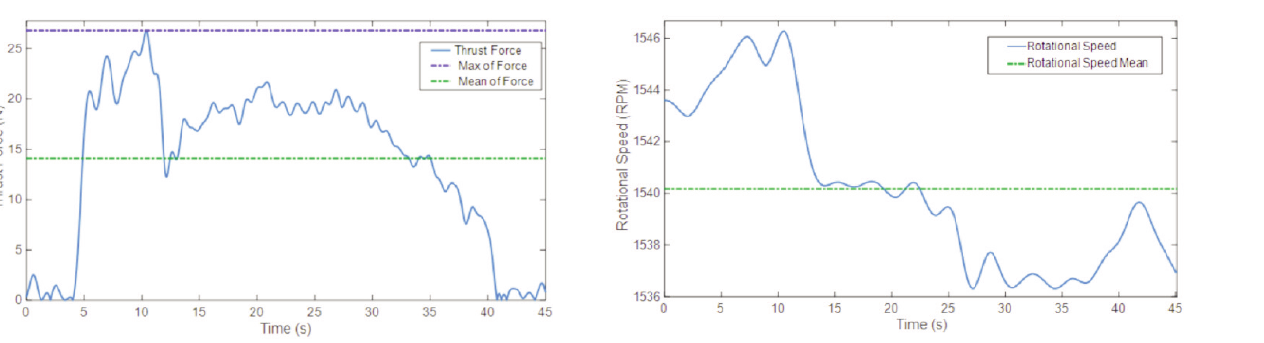
The force variation when the drill approaches the bone Fig. 3: and passed through the proximal cortex – medulla – distal cortex (Drill 3).